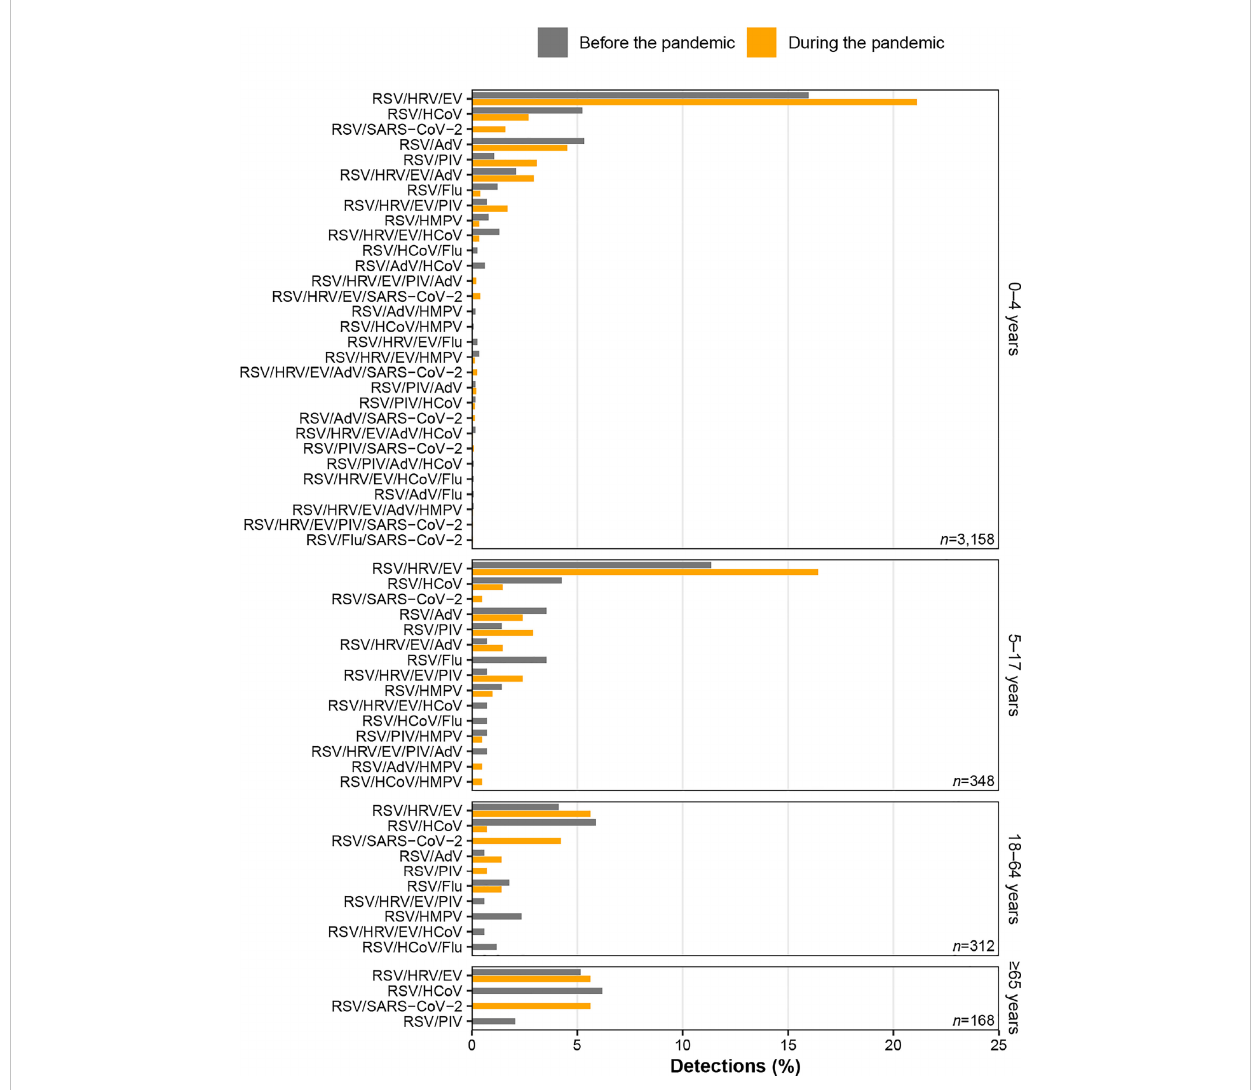
FIGURE 3 Proportions of samples testing positive for respiratory syncytial virus (RSV) and other respiratory viruses (among all RSV-positive samples) before and during the COVID-19 pandemic, strati fi ed by age group. Samples were tested from January 2018 to November 2022 in Nashville, Tennessee. RSV, respiratory syncytial virus; HRV/EV, human rhinovirus/enterovirus; HCoV, human coronaviruses; AdV, adenovirus; PIV, parain fl uenza viruses 1 – 4; Flu, in fl uenza A and B; HMPV, human metapneumovirus; SARS-CoV-2, severe acute respiratory syndrome coronavirus